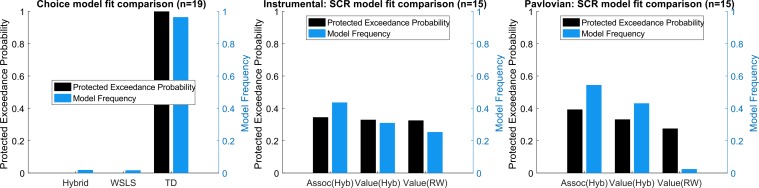
Experiment 1: Model protected exceedance probability.Choice fitting remains similar to the original exceedance probability, however, SCR fitting comparison becomes less clear regarding best fitting model.